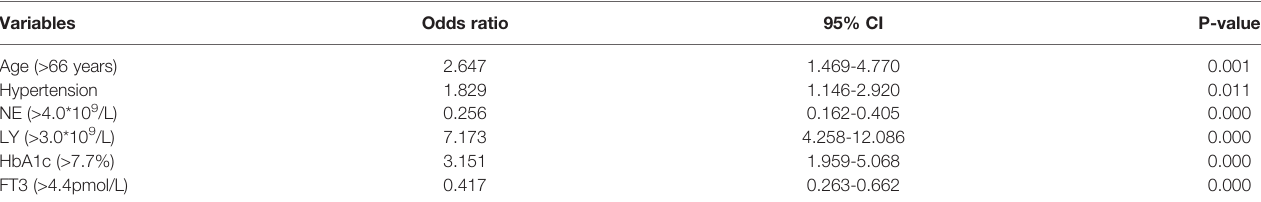
TABLE 4 | Multivariate analysis (Multiple logistic regression analysis) of factors associated with diabetic peripheral neuropathy. Variables Odds ratio 95% CI Age (>66